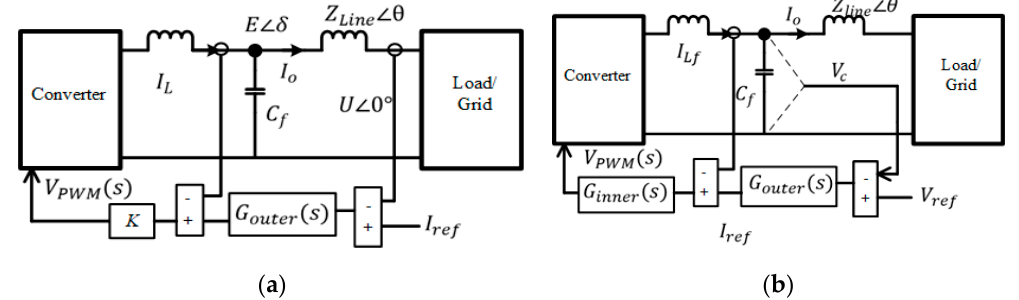
Figure 2. The control structure of two strategies. ( a ) The current control mode (CCM) control structure; ( b ) The voltage control mode (VCM) control structure.